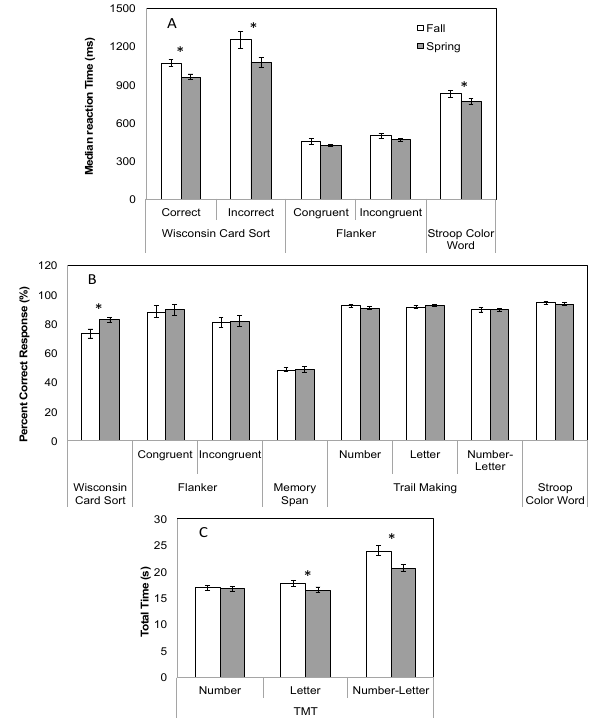
Figure 1. Performance metrics (( A ) median reaction time; ( B ) percent correct responses; ( C ) total time) across Fall/Spring test points on the neurocognitive test battery. The symbol * indicates a significant ( p < 0.05) difference between the Fall and Spring semester within each test. Error bars represent standard error.